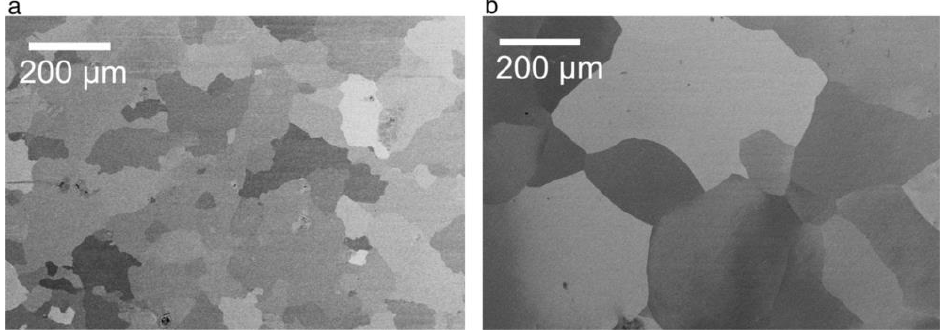
Figure 6. SEM micrographs of highly pure 99.999% Al sheets prior to thermal treatment ( a ) and after annealing at 500 °C for 3 days ( b ). Reproduced with permission from [95]. Copyright 2008 Elsevier.